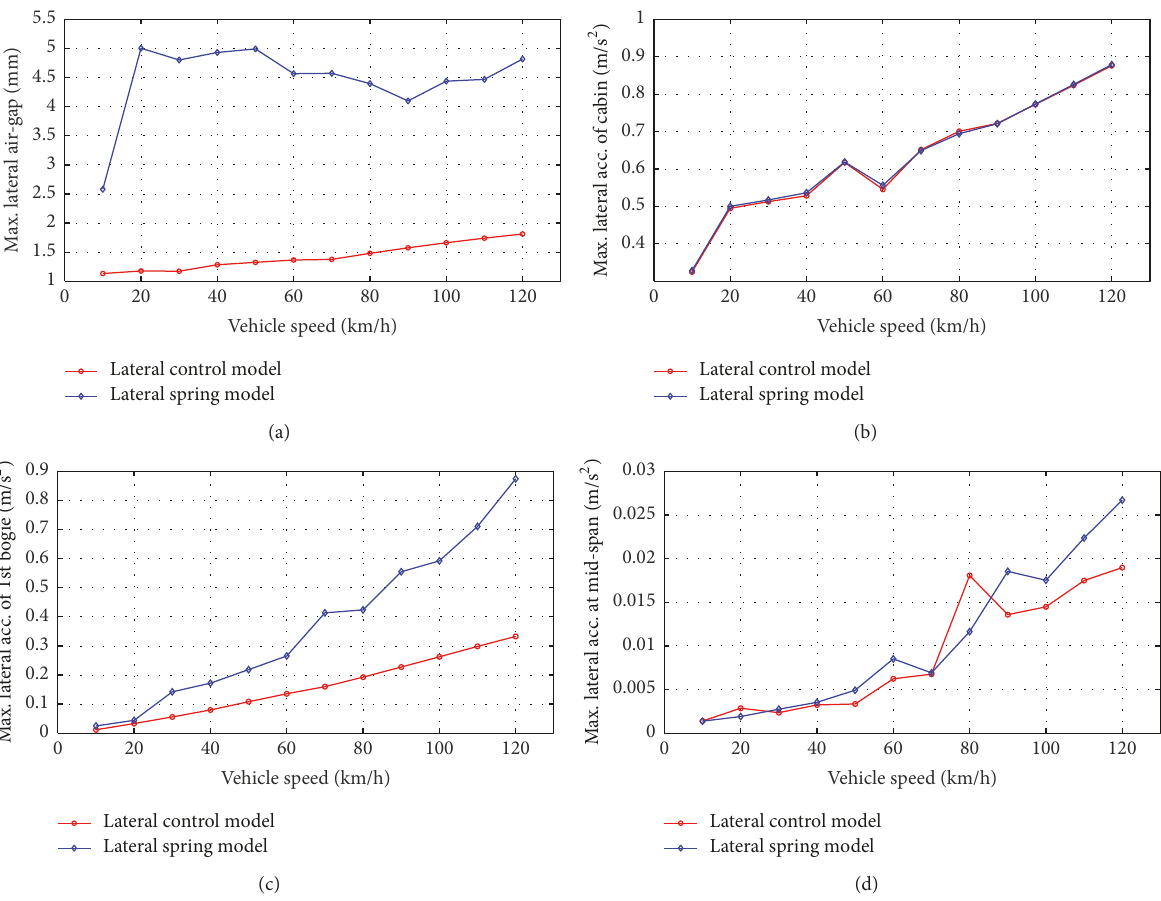
Figure 13: Maximum responses for the two kinds of lateral EMS type ( U = 20m/s): (a) lateral air-gap, (b) lateral acceleration at the position of 1st sensor, (c) lateral acceleration of 1st bogie, (d) lateral acceleration at mid-span.